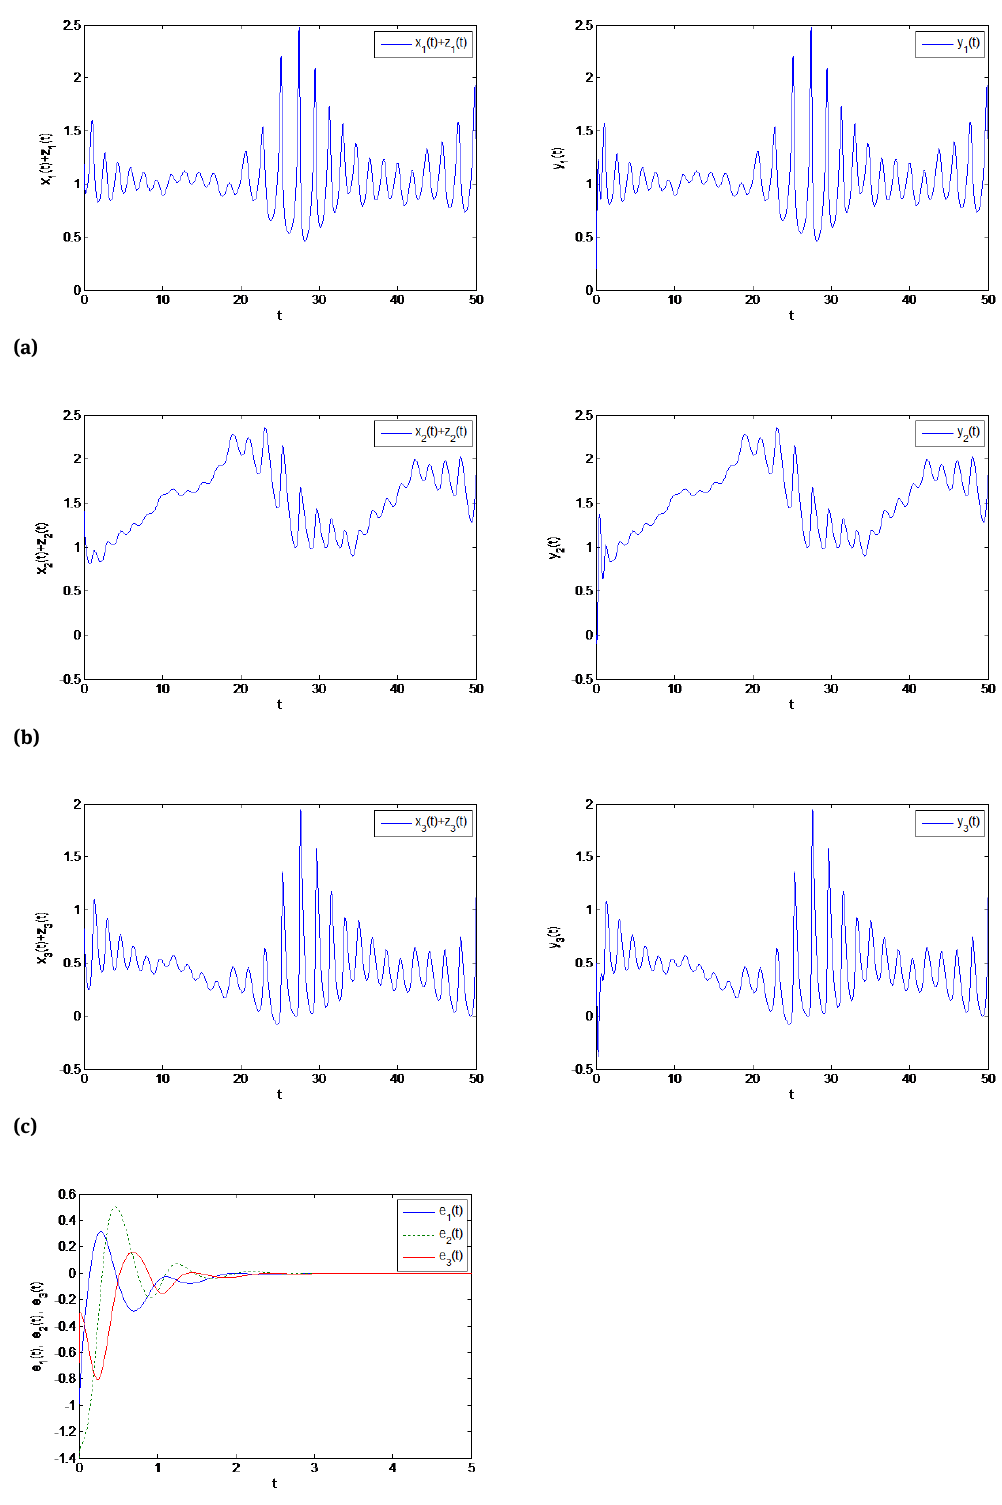
Fig. 2: Combination synchronization among three fractional order chaotic systems (5), (6) and (7) for fractional order q = 0.95 : (a) between x 1 ( t ) + z 1 ( t ) and y 1 ( t ) , (b) between x 2 ( t ) + z 2 ( t ) and y 2 ( t ) , (c) between x 3 ( t ) + z 3 ( t ) and y 3 ( t ) , (d) the evaluation of error function e 1 ( t ), e 2 ( t ) sand e 3 ( t )